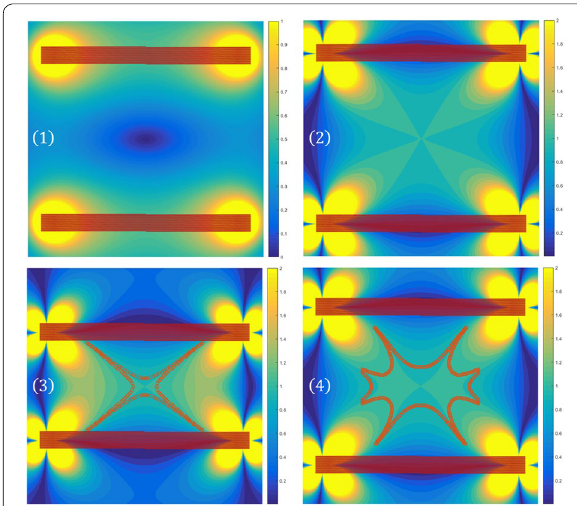
Figure 7 Uniform gradient field distribution and its gradient along z- axis of the coil pair